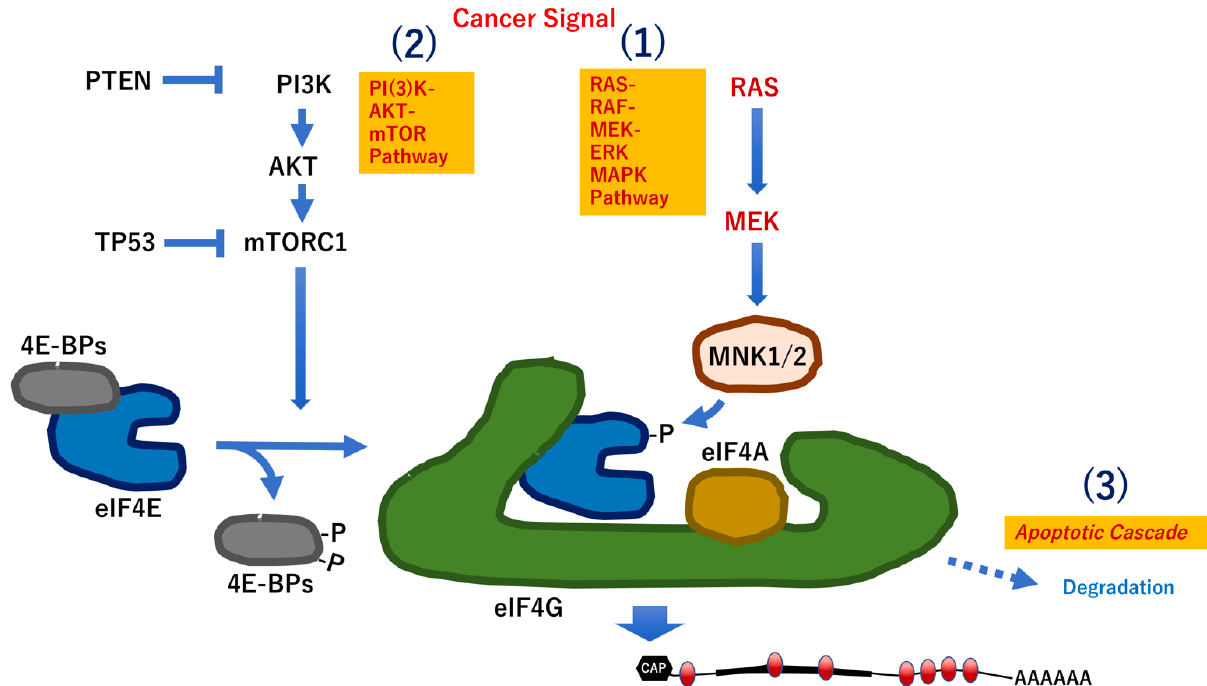
Figure 3. RNA modification mechanism in IBD. Generally, three mechanisms are involved in the activation of peptide translation of mRNAs. PTEN, phosphatase and tensin homolog; TP53, Tumor Protein P53; AKT, AKT serine/threonine kinase 1; mTORC1, mechanistic/mammalian target of rapamycin complex 1; eIF4E, eukaryotic translation initiation factor 4E; 4EBP, eukaryotic translation initiation factor 4E binding protein; eIF4G, eukaryotic translation initiation factor 4 gamma; eIF4A, eukaryotic translation initiation factor 4A; MNK1, MAPK interacting serine/threonine kinase 1; MNK2, MAPK interacting serine/threonine kinase 2; MAPK, mitogen-activated protein kinase; ERK1, mitogen activated protein kinase 3 (MAPK3); ERK2, mitogen activated protein kinase 1 (MAPK1); MEK1, MAP2K1, mitogen-activated protein kinase kinase 1; RAS, RAS proto-oncogene, GTPase; RAF, RAF-1 proto-oncogene, serine/threonine